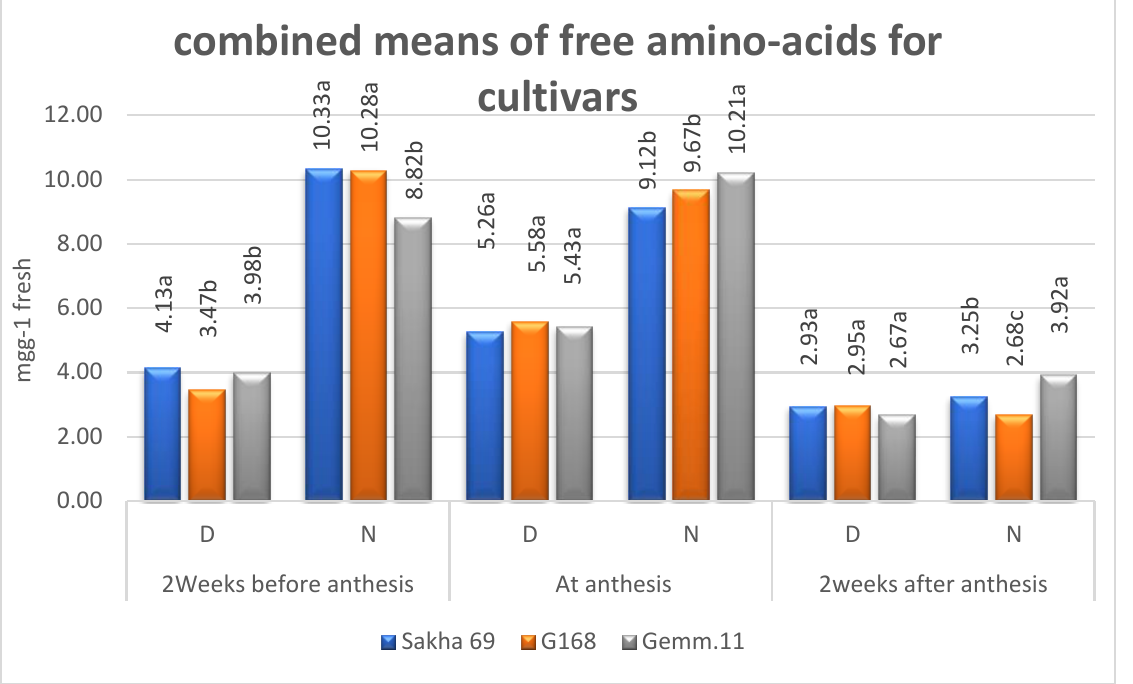
Figure 5. Combined means of soluble proteins for cultivars under drought stress (D) and irrigation (N); means followed by the same letter in each environment are not significant at the 0.05 level of probability according to LSD test.